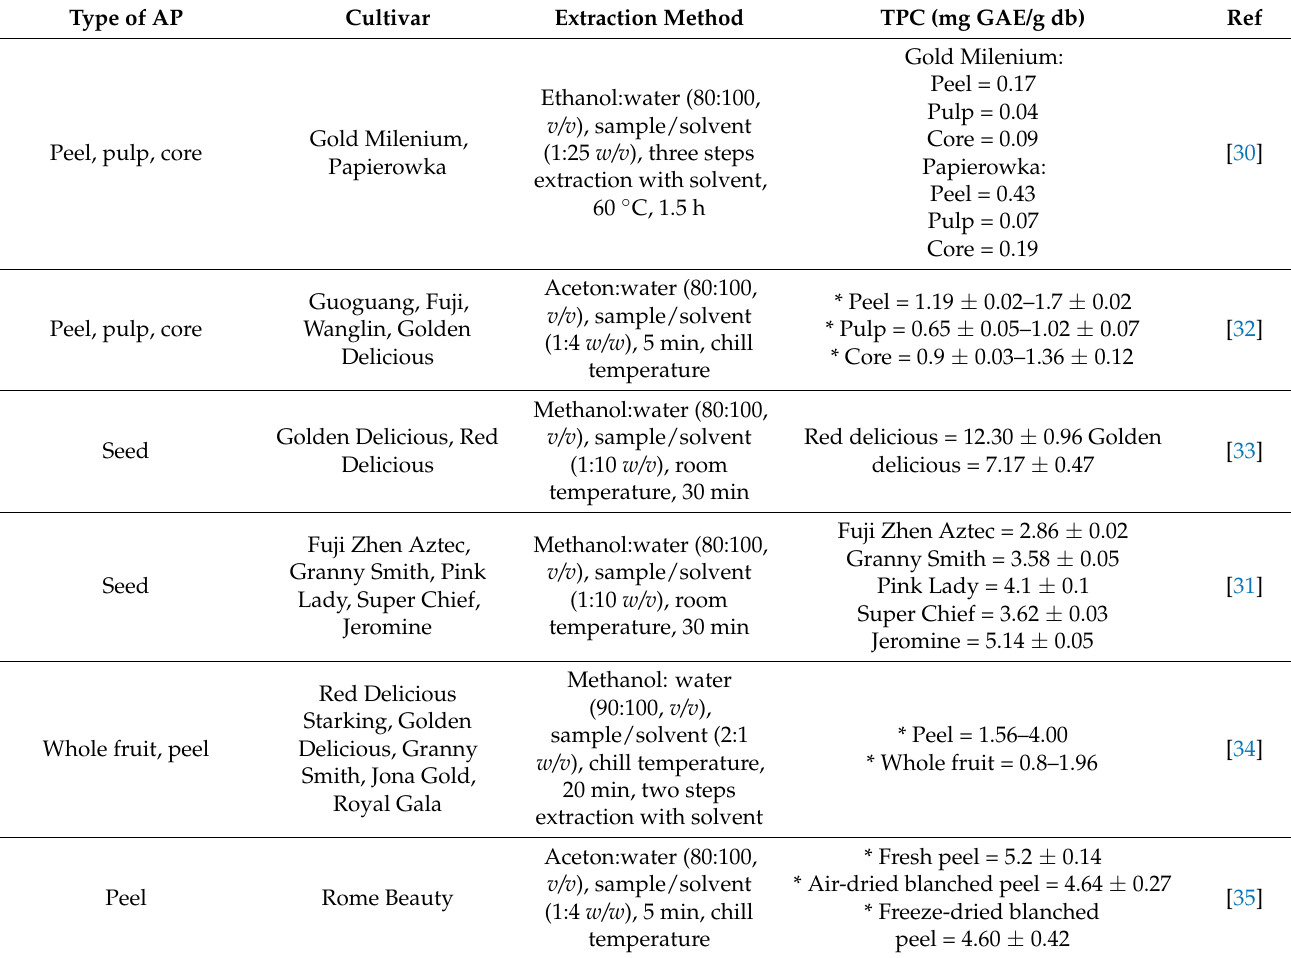
Table 2. A summary of the previous reports on the total polyphenolic compounds (TPC) content that was obtained from different types of apple pomace